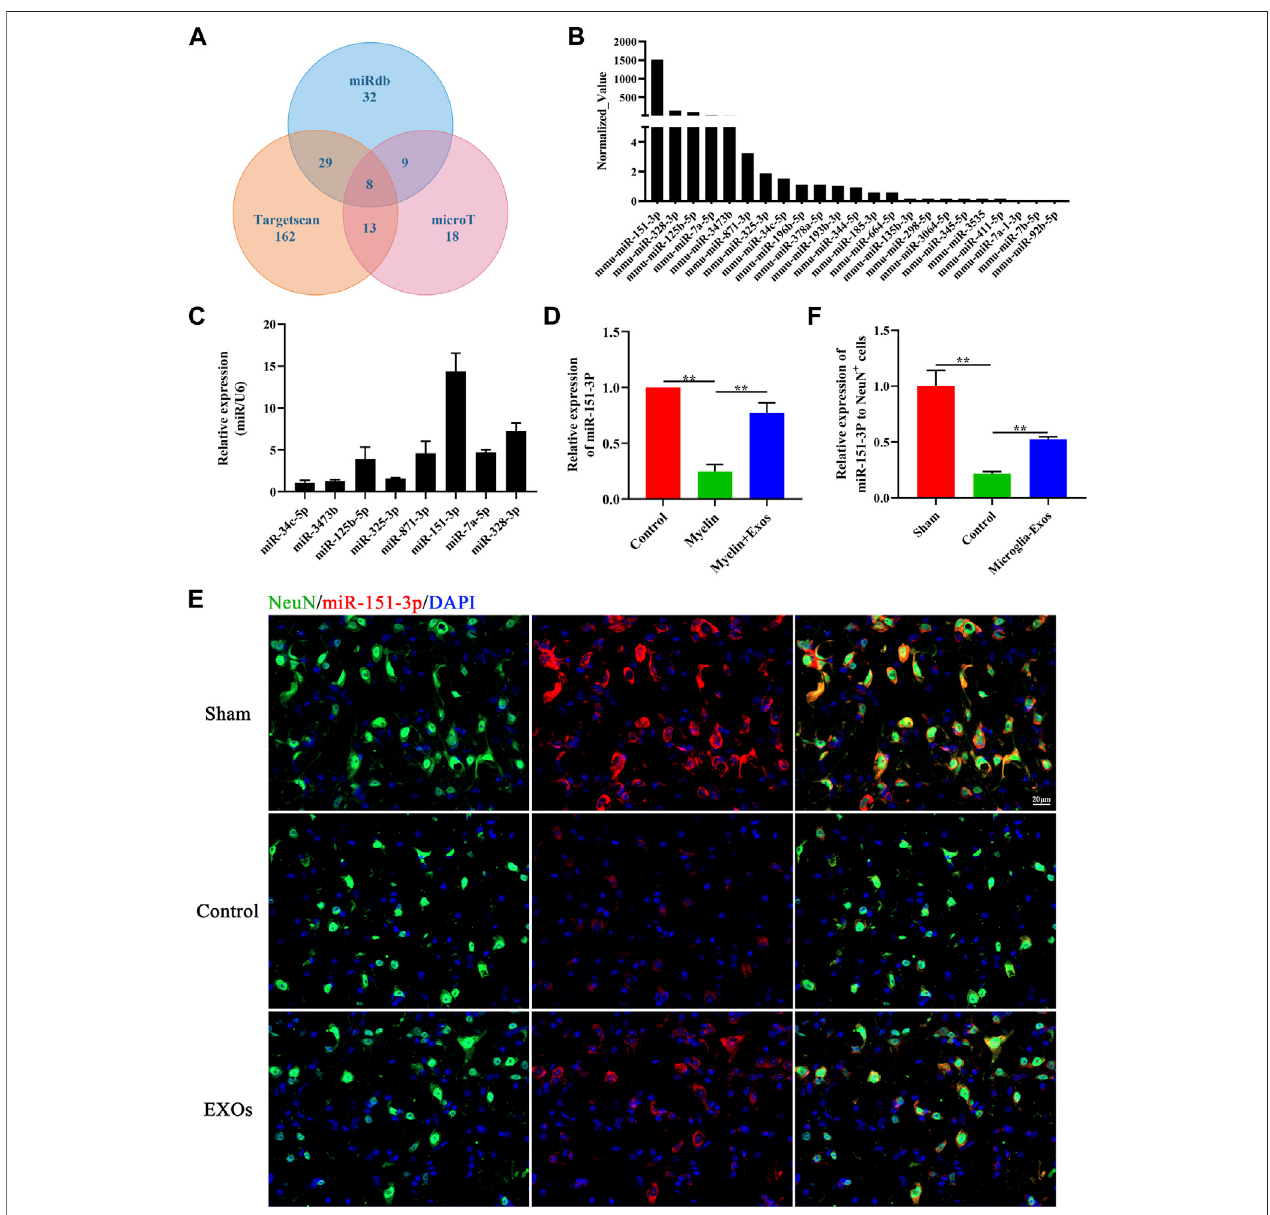
FIGURE 5 | miR-151-3p is enriched in Microglia-Exos and transfer to neurons . (A) Predicted microRNAs targeted to p53 by TargetScan, micro T, and miRDB databases. (B) Top 23 highly expressed microRNAs of microglia-Exos that targeted to p53 are listed. (C) qRT-PCR analysis of the top eight expressed microRNAs in Microglia-Exos.N (cid:1) 3pergroup. (D) RelativeexpressionofmiR-151-3pincontrol,myelindebris,andmyelindebris+Microglia-Exo – treatedneuronsbyqRT-PCR.N (cid:1) 3 per group. (E) In situ hybridization of miR-151-3p (red) and fl uorescence staining of NeuN (green) of sham, control, and microglia-Exo – treated groups at the